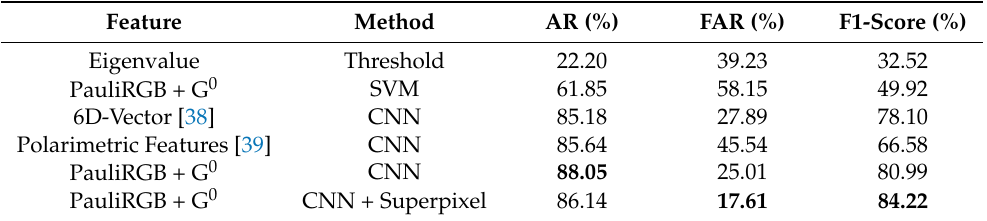
Table 1. Different methods of building extraction effects under ESAR data.